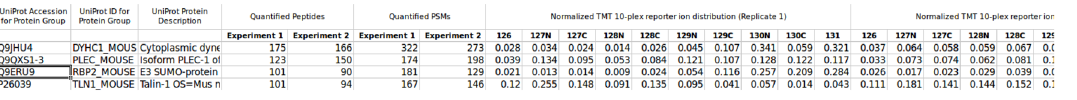
Figure 3. A screenshot of the data in the